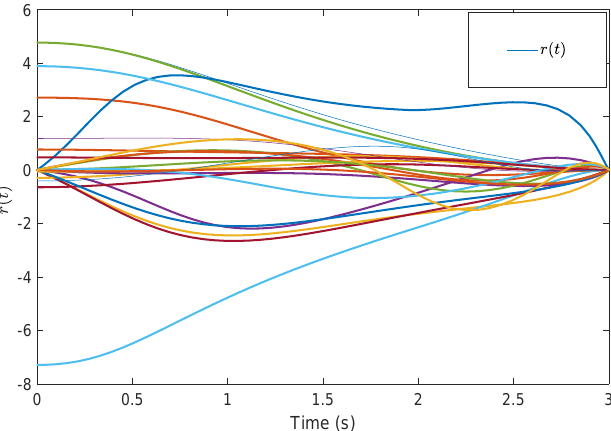
Figure 5. Containment consensus variable r (t) by the prescribed-time Controller (62).